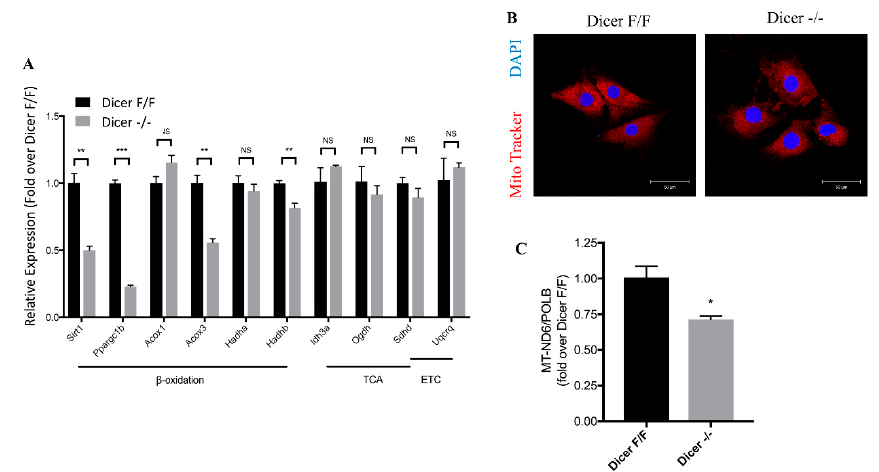
Figure 5. ( A ) Comparison of relative mRNA levels of genes related to mitochondrial fatty acid oxidation in mouse Dicer F/F and Dicer -/- C-MSC. The amount of mRNA was normalized using β -actin. TCA, tricarboxylic acid cycle; ETC, electron transport chain. Results are shown as mean ± SEM ( n